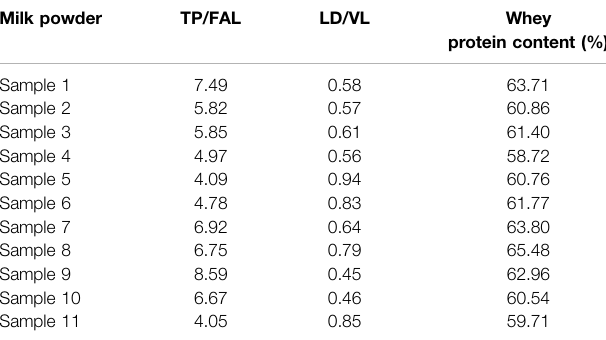
TABLE 7 | Whey protein content of different brands of domestic and international formula milk